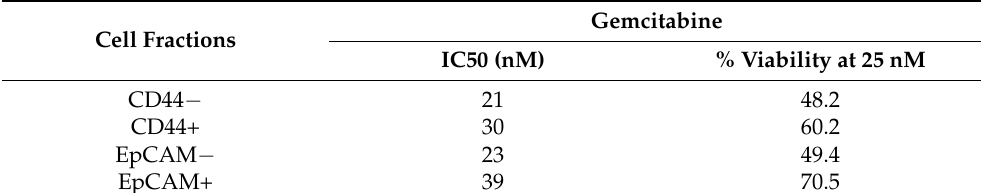
Table 1. When the survival of parental BxPC-3 PDAC cells treated with different concen- trations of verapamil and gemcitabine was analyzed, it was found that 25 and 50 µ M concentrations of verapamil exerted the best chemotherapeutic effects with a gemcitabine concentration of 0.001 µ g/mL (Figure 3, p < 0.05). The survival of the CSCs CD44+/CD44 − of BxPC-3 PDAC cells treated with different concentrations of verapamil and gemcitabine was also assessed, which revealed that 25 and 50 µ M concentrations of verapamil ex- erted the best chemotherapeutic effects with a gemcitabine concentration of 0.001 µ g/mL (Figure 4, p < 0.05). Table 1. IC50 values for gemcitabine in respective BxPC-3 CSCs cell fractions. Cell Fractions